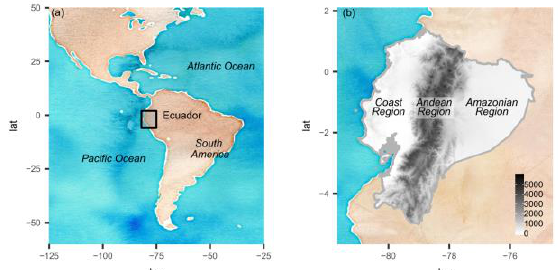
Figure 1. Study area and main climate regions of Ecuador: Coast, Highlands (Andes) and Amazon.